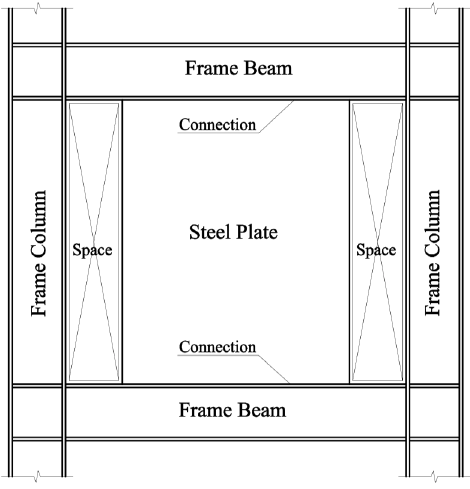
Figure 1. Steel plate shear walls (SPSWs) with two-side